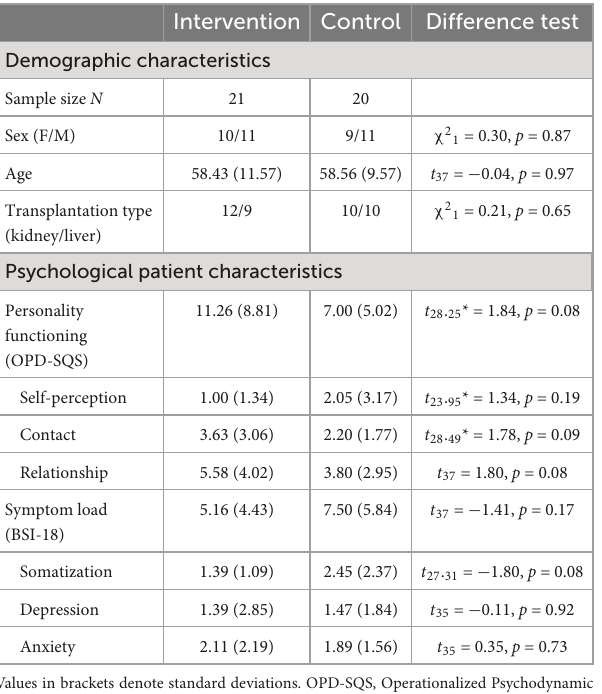
TABLE 1 Sample characteristics. TABLE 2 Correlations between personality functioning (OPD-SQS) and symptom load